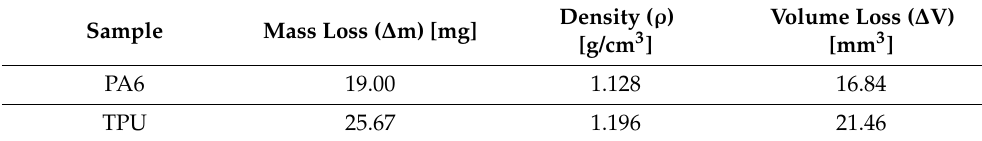
Table 4. Wear amount and densities of polymeric samples .